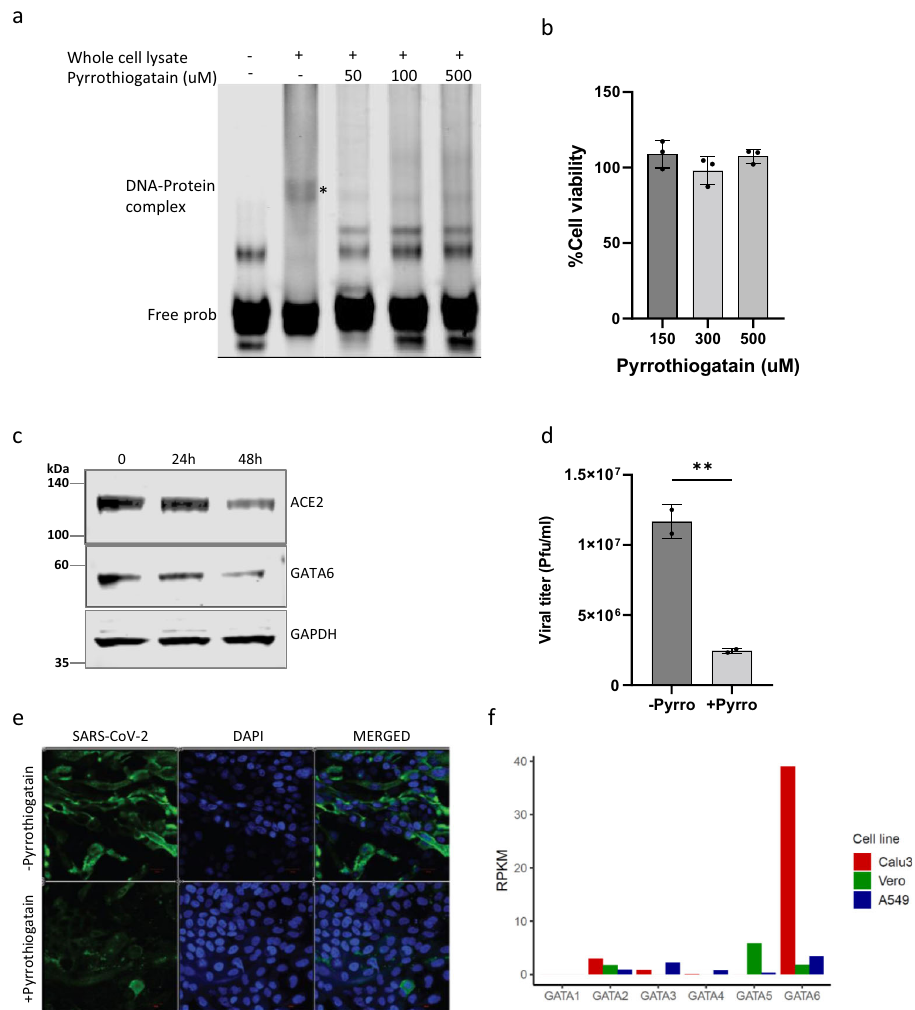
Fig. 6 GATA6 may serve as a potential host-directed therapeutic target. a Electrophoretic mobility shift assay (EMSA) of lysates from HEK293T cells overexpressing GATA6 with labeled oligonucleotides derived from the promoter region of ACE2 in the presence of various concentrations of Pyrrothiogatain (0 – 500 µ M). b The effect of various concentrations of Pyrrothiogatain on Calu-3 cell proliferation was determined using the XTT assay and presented as a percentage of cell viability of untreated cells. Data were analyzed from three biologically independent experiments by one-way ANOVA with Brown-Forsythe test. c Calu-3 cells were treated with 500 uM Pyrrothiogatain and the expression of GATA6 and ACE2 were analyzed by western blot at the indicated time. d Real-time PCR quanti fi cation of WT-SARS-CoV-2 in Calu-3 cells that were pretreated with 500 uM Pyrrothiogatain. Cells were infected using MOI = 0.002 for 48 h. Data were analyzed from two biologically independent experiments by two-tailed student ’ s t -test. Shown are means ± SD. ** p < 0.01. e Calu-3 cells pretreated with 500 uM Pyrrothiogatain and infected with WT-SARS-CoV-2. Cells were fi xed 24 h post-infection and stained with antisera against SARS-CoV-2 (green) and DAPI (blue). Scale bar, 20 mm. f mRNA read densities (reads per kilobase million, RPKM) of the six members of the GATA family in uninfected Calu-3 (red), Vero-E6 (green), and A549 cells (blue) 66 – 68 . Representative images of three biologically independent experiments are shown. Source data are provided as a Source Data fi 500 µM) for an additional 48 h. Then, XTT reagent was added for 15 min before reading the change in absorbance at 650 and 475 nm using the SpectraMax 250 plate reader (Molecular devices). Speci fi c absorbance measurements were given as the mean± SD absorbance calculated from two repeat wells/samples. The mean speci fi c absorbance was normalized at each time point to that of the non-treated control. For crystal violet staining, following 48h of SARS-CoV-2 infection the medium was removed from the cells that were then fi xed and stained with 0.1% crystal violet solution (Biological Industries, Israel) for 5min. Then stain was aspirated and plates were rinsed once with tap water and air-dried. Analysis of GATA6, CUL5, and IRF6 expression in different cell lines . Pub- lished mRNA-seq data used for A549, Vero-E6, and Calu-3 cells are from Kinori et al. 2016, Finkel et al. 2021a and Finkel et al. 2021b., respectively. Gene level values were normalized to TPM (transcripts per million) by dividing the published RPKM values by the sum of each sample and multiplying by one million. 94 °C for 15sec, 60 °C for 35sec. Primers and probes (listed in Supplementary